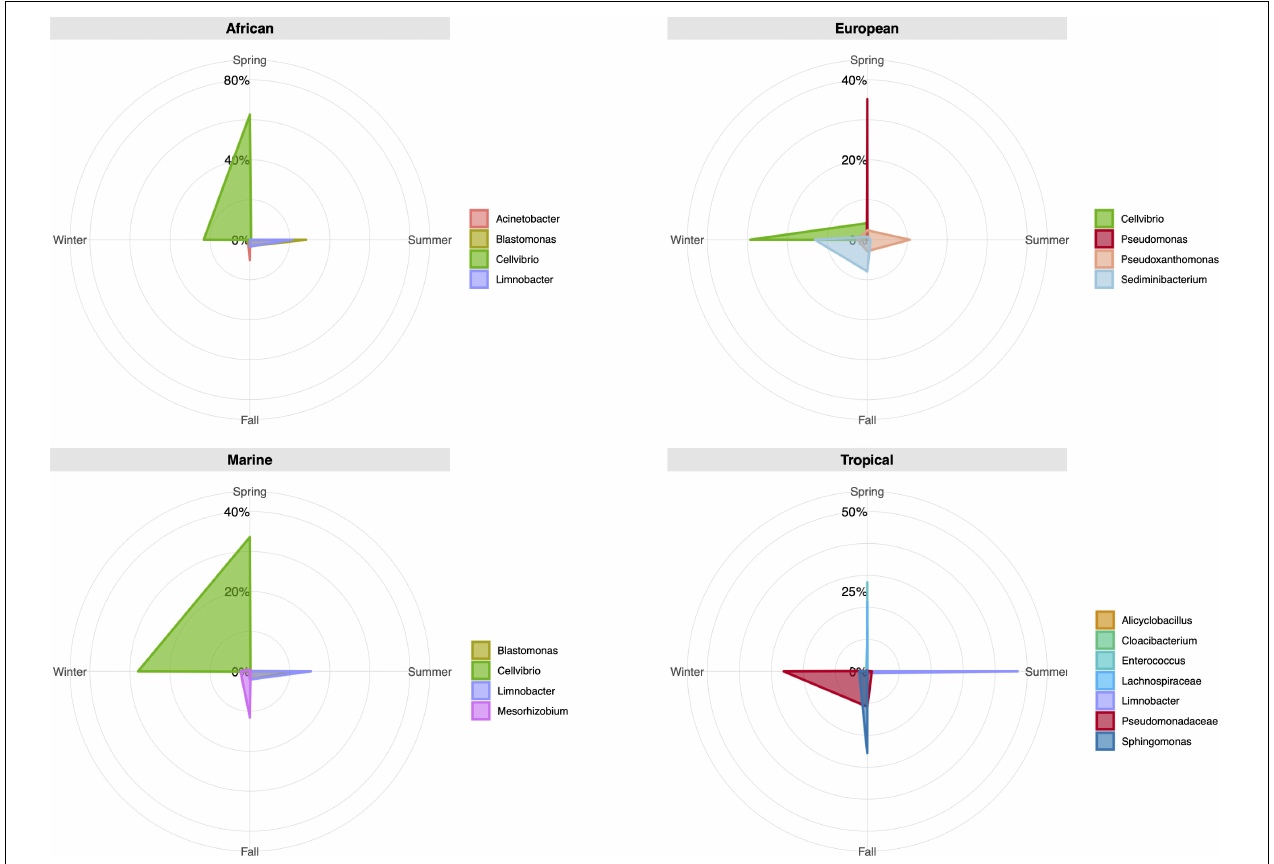
FIGURE 5 | Radar chart presentation of relative operational taxonomic unit (OTU) abundance of taxa at the genus level for different seasons and wind back trajectories. Each chart shows the season levels for the most abundant bacterial genera ( > 10%). The values along each axis of the radar chart are connected linearly to visualize genera relative abundance as a